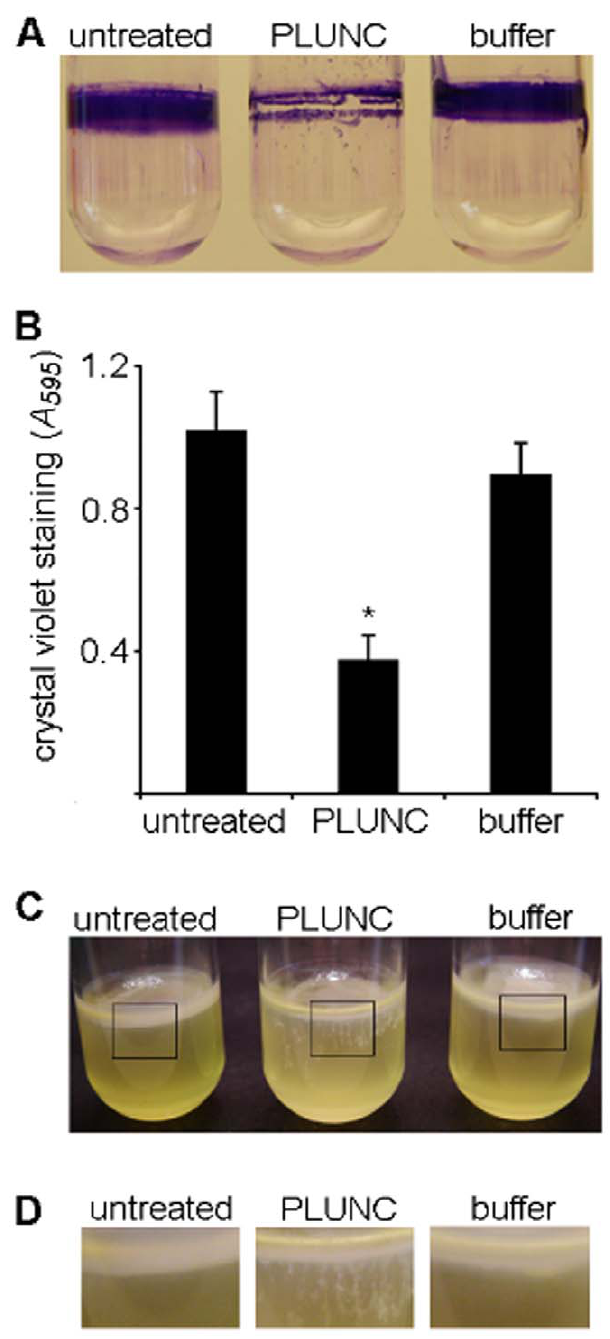
Figure 7. PLUNC inhibits biofilms growing at the air-surface interface. (A) Crystal violet staining of P. aeruginosa PA14 biofilms shows that PLUNC (100 m g/mL) reduced the biofilm biomass accumu- lating on the sides of culture tubes after 72 hours of growth. (B) The amount of crystal violet retained by biofilms was quantitated using optical density measurements. Growth of PLUNC-treated biofilms (n=3) was significantly inhibited compared to non-treated and buffer-treated biofilms. Error bars show standard deviation. * P , 0.025. (C) Biofilms formed at the air-liquid interface of unshaken cultures after 48 hours of growth. (D) Magnification of areas outlined in panel C shows that in media containing 100 m g/mL PLUNC, biomass spontaneously separates from the air-liquid interface biofilm and sinks toward the bottom of the culture tube.